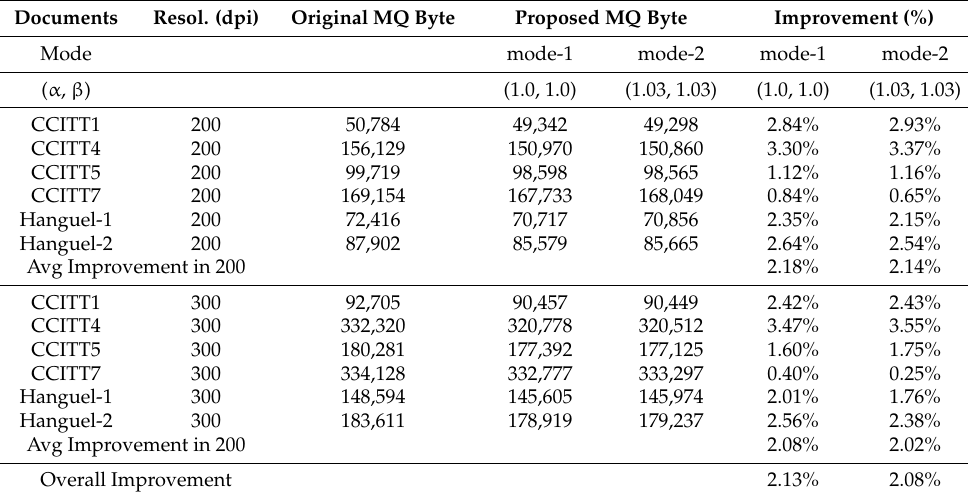
Table 13. Experimental results for each mode using 8-level LUT for binary images.